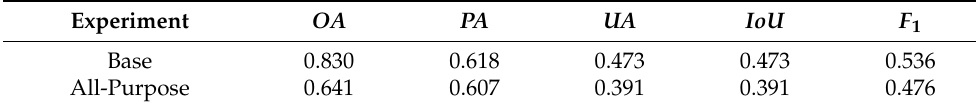
Table 12. Global metrics for the experiment with UNet on